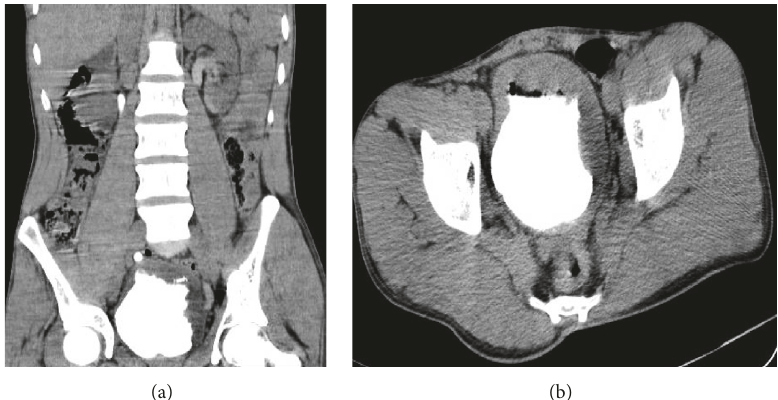
Figure 1: Abdominopelvic CT-scan of patient. (a) Axial view showing bilateral hydronephrosis and nonuniform decreased cortex; (b) horizontal view showing multiple filling defects in bladder.